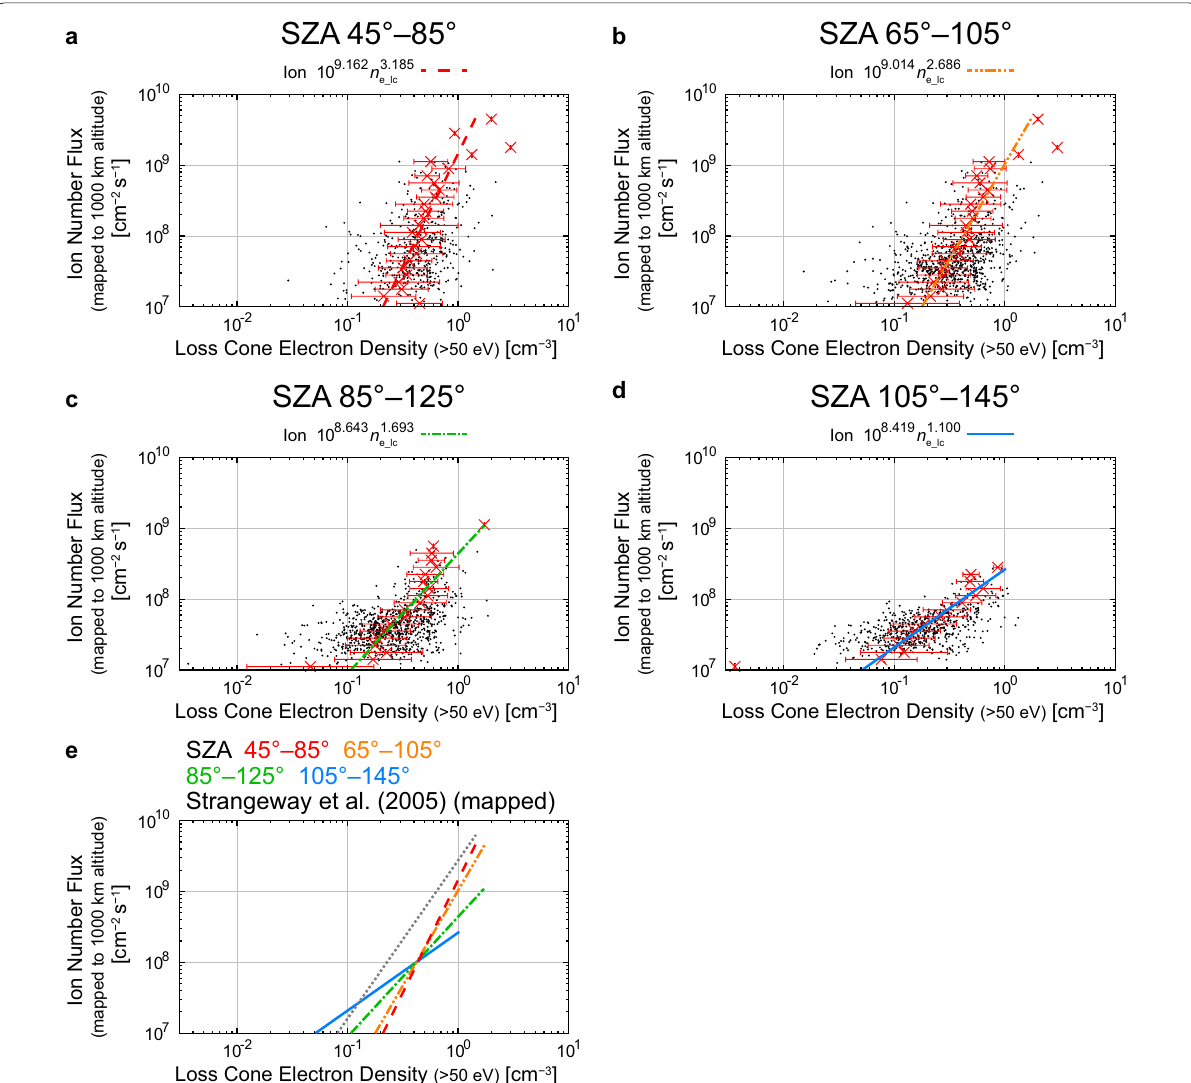
Fig. 3 Relations between the electron density in the loss cone (< 50 eV) and the mapped outflowing ion number flux in the SZA ranges of a 45°–85°, b 65°–105°, c 85°–125°, and d 105°–145°, and f comparisons among the derived empirical relations in these SZA ranges and the empirical formula derived by Strangeway et al. (2005) (their Eq. 4) (multiplied by a factor of 2.9 to correct for the altitudinal difference of the ion number flux) (dotted gray line). Weighted averages and standard deviations of the logarithmic values are plotted as red crosses and solid lines (as error bars). Dotted lines indicate the empirical relations derived by the fitting. In Fig. 3e, the empirical relations in the SZA ranges of 45°–85°, 65°–105°, 85°–125°, and 105°–145° are shown using red-dashed, orange dashed-dotted-dotted, green dashed-dotted, and blue solid lines,